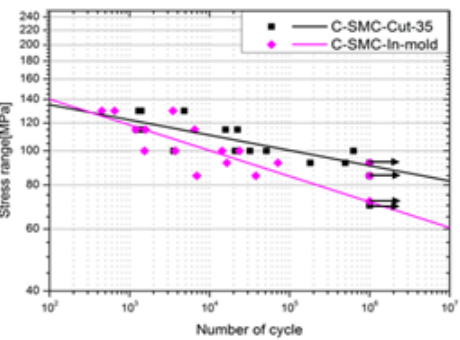
Figure 12. S–N curve with fatigue test result comparison between C-SMC-Cut-35 and C-SMC-In-mold.